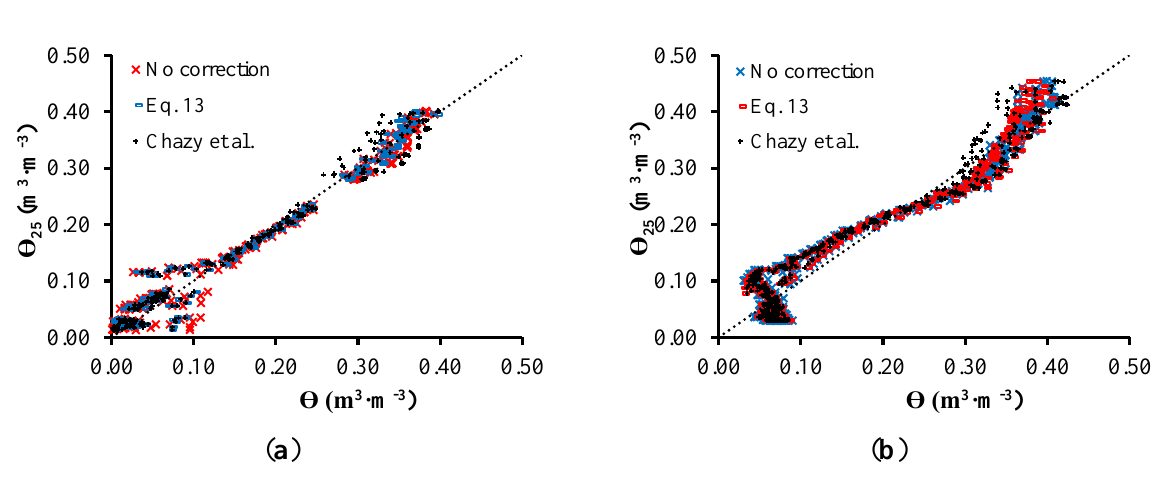
Figure 11. ( a ) θ-θ 25 relationship for sandy soil ( a ) and clay soil ( b ).